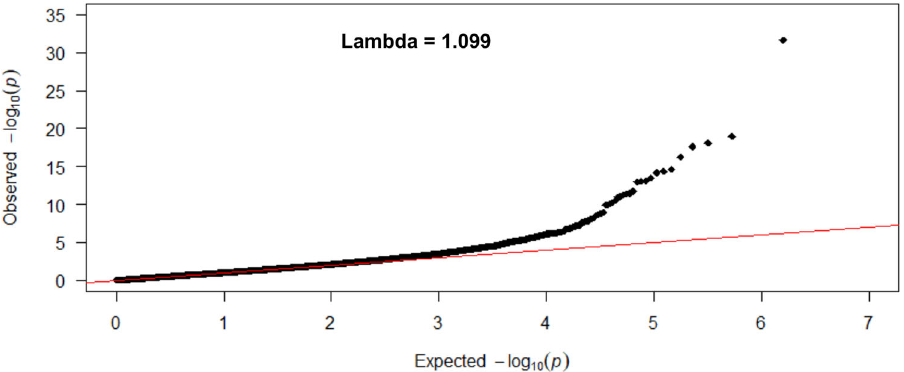
Figure 2. Quantile-quantile (QQ) plot for CpG-site association in the EWAS for smoking (5 levels) in Figure1.